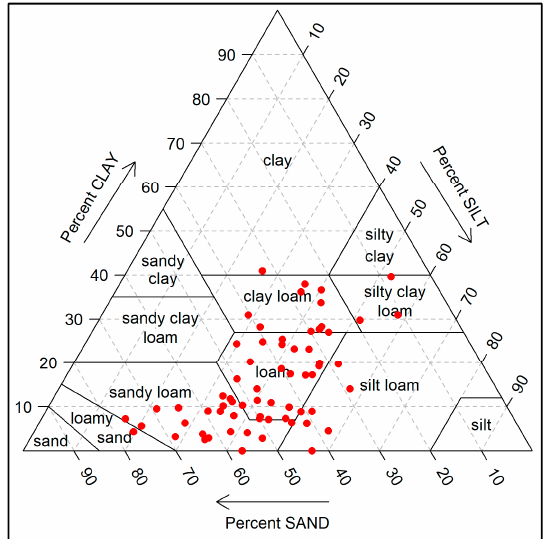
Figure 2. All stations distributions over the United State Department of Agriculture (USDA) soil texture triangle.